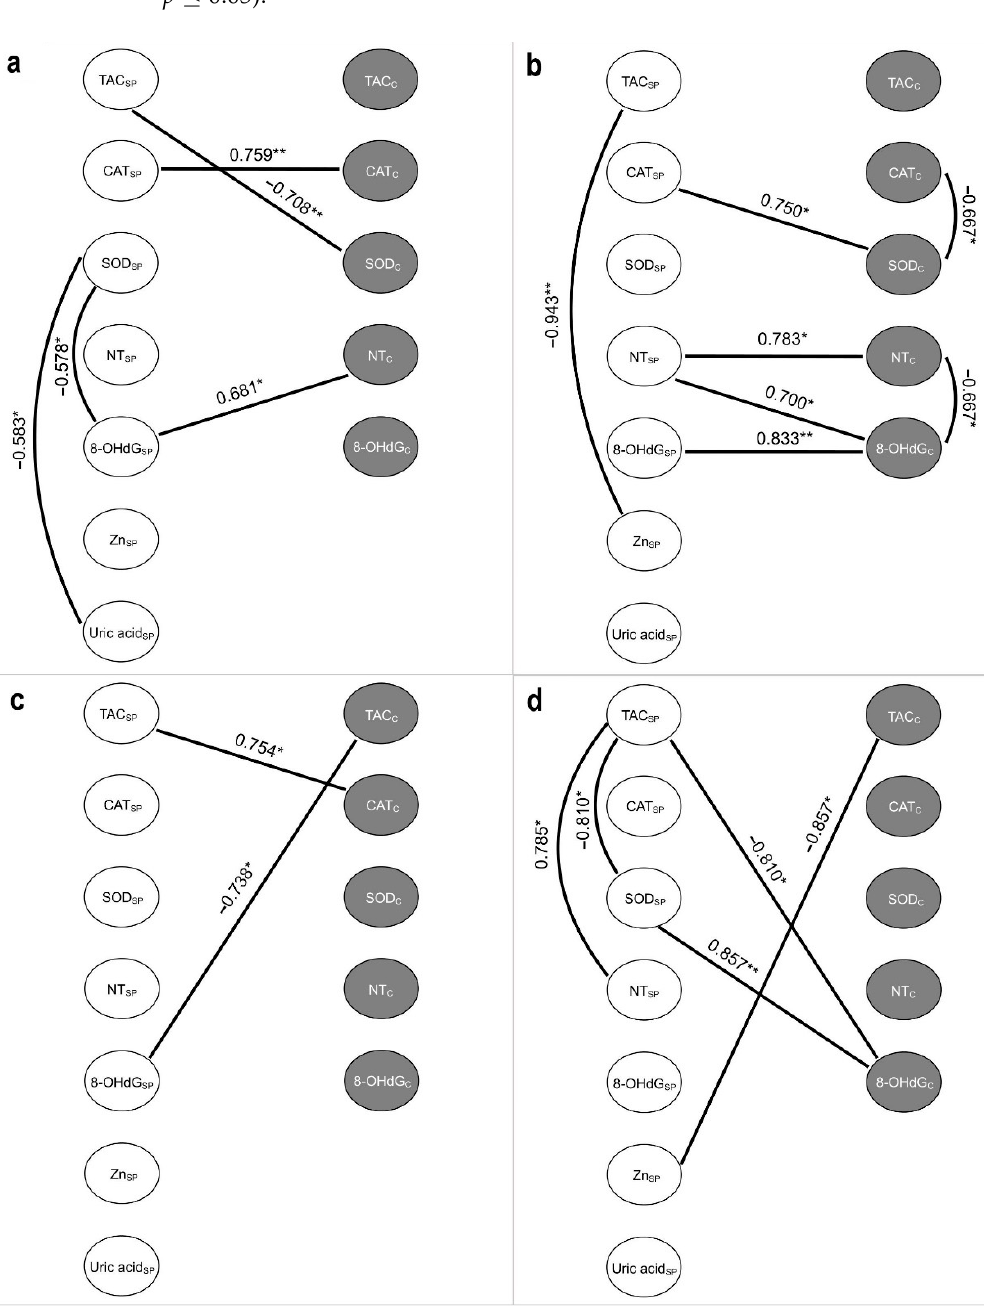
Figure 5. Correlation pleiades of the studied markers in groups ( a ) COVID − , TUNEL<15; ( b ) COVID+, TUNEL<15; ( c ) COVID − , TUNEL>15; ( d ) COVID+, TUNEL>15. 8-OHdG—8-hydroxy-2 ′ -deoxyguanosine; CAT—catalase; NT—nitrotyrosine; SOD—superoxide dismutase; TAC—total antioxidant capacity; С (subscript)—cellular; SP (subscript)—in seminal plasma. The Spearman correlation coefficient was used to identify the strength and direction of the relationship between studied markers. *— p ≤ 0.05; **— p ≤ 0.01.